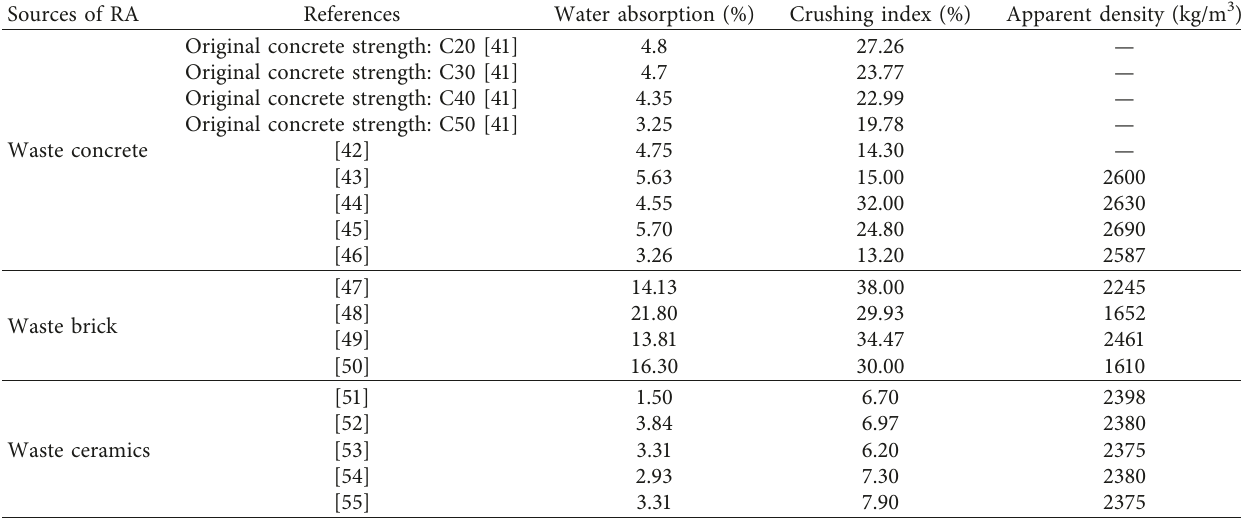
Table 2: Physical properties of RA obtained from various sources.